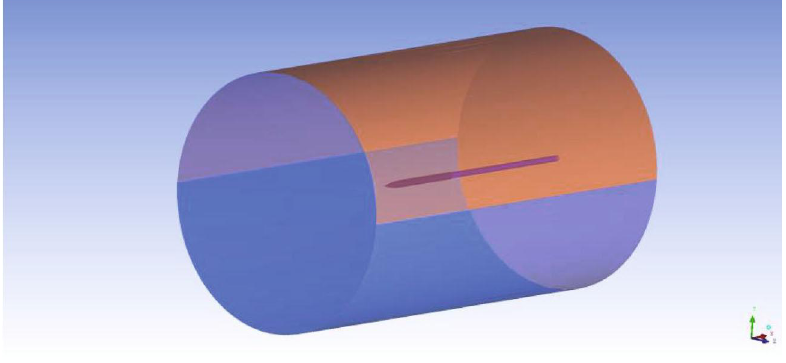
Figure 6: Diagram of boundary